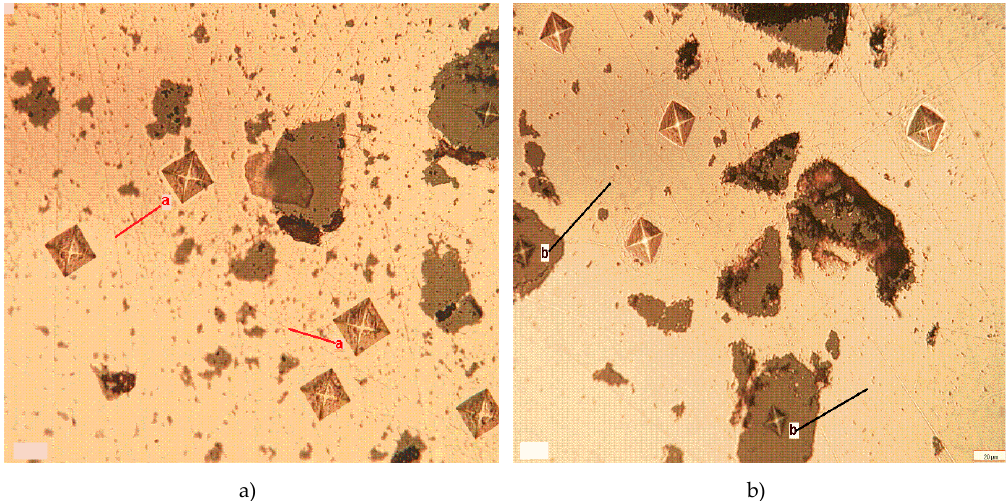
Figure 20. Optical images of the Vickers microhardness measurements on Cu matrix ( a ) and on Fe 3 O 4 particle agglomeration ( b ).